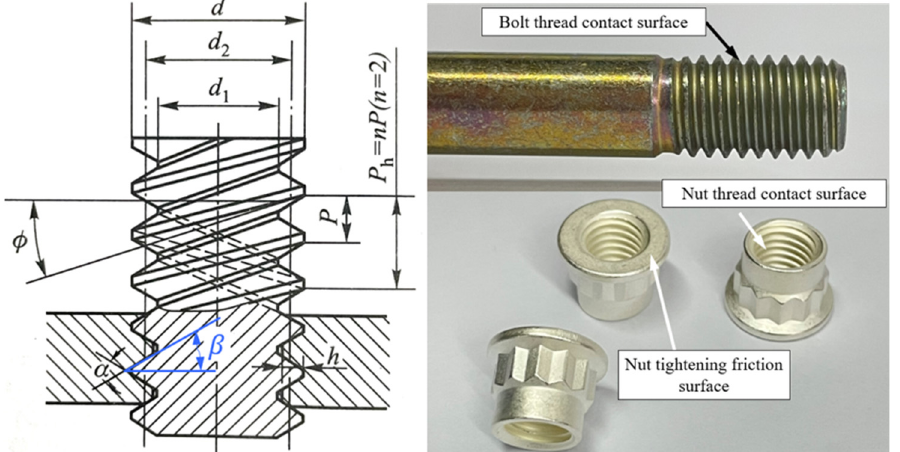
Figure 3. Main geometric parameters of the thread and contact surface position.